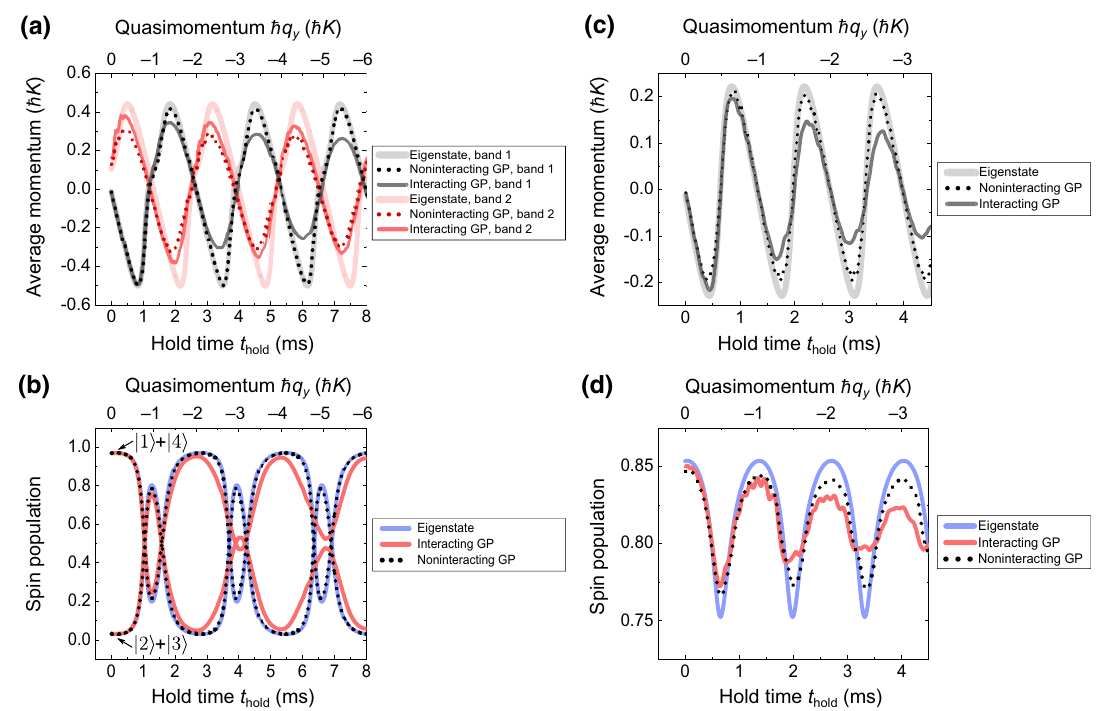
FIG. 9. Comparison between GP (interacting and noninteracting) and eigenstate calculations. (a) Calculations of the average momentum versus t hold for the transport in band 1 and band 2 in Fig. 2(b). The spin population versus t hold corresponding to the trans- port in band 1 is shown in (b). (c) Calculations of the average momentum versus t hold for the transport in Fig. 3(d). The corresponding spin population versus t hold is shown in (d). (including the fitting uncertainty of ± 0.025 π ) obtained by monitoring the drift of the experimental curve (Fig. 10) in